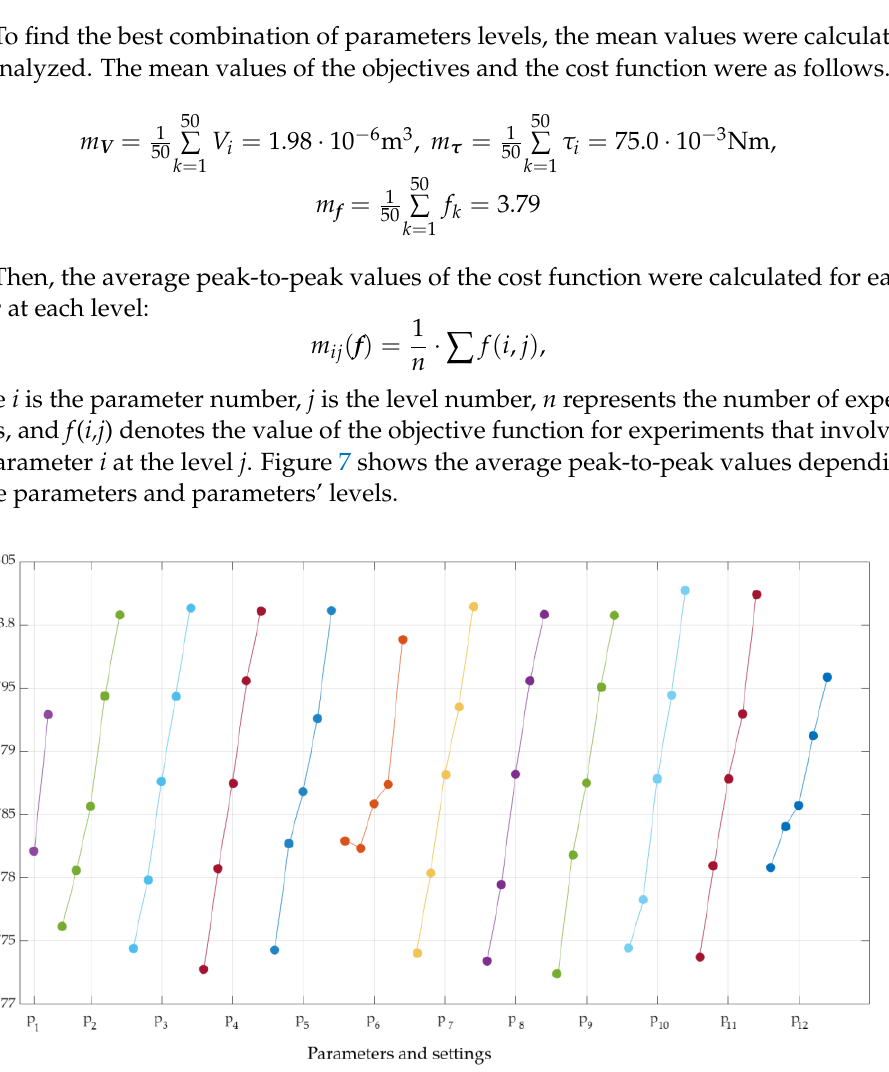
Figure 7. Parameter effects on the objective function. Table 4. Effects of different parameters on the cost function.